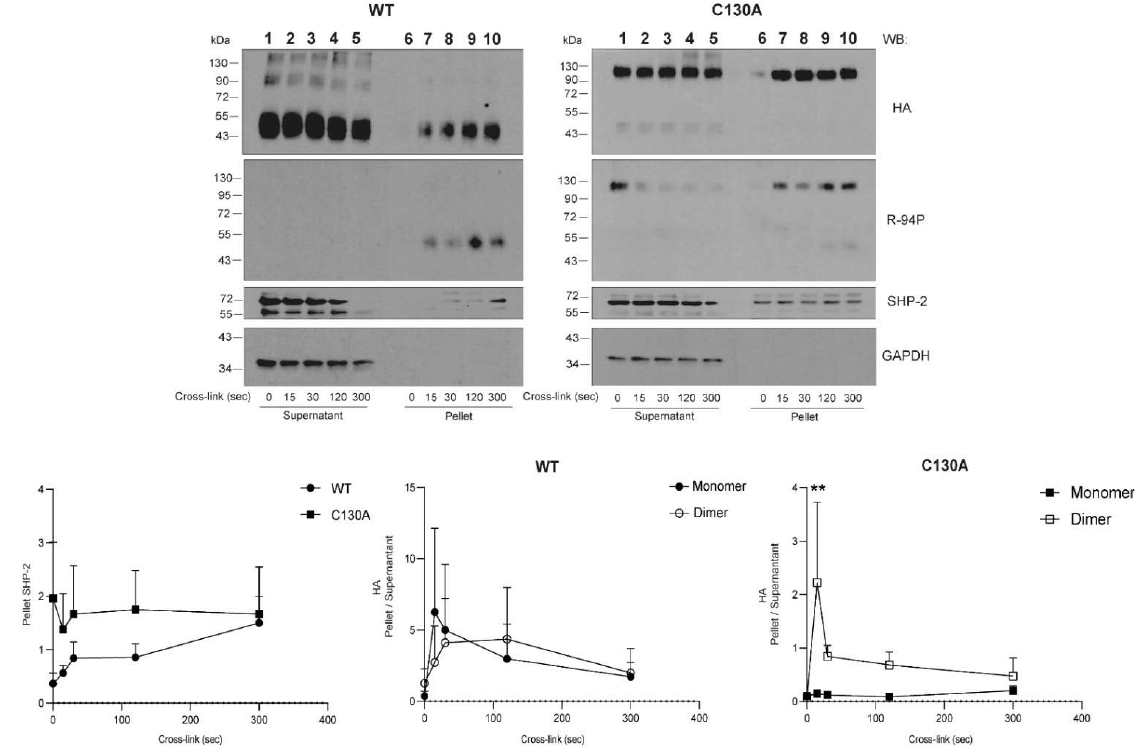
Figure 5. The C130 mutant enhances the recruitment of SHP-2 to the insoluble membrane fraction. Wild-type (WT) CLEC12A and C130 expressed transiently in HEK-293T cells were cross-linked with an anti-HA or a mouse isotype control antibody before cell lysis at the indicated time points as described in Materials and Methods. CLEC12A translocation from the NP40 soluble (supernatant (SN)) to insoluble pellet (P) was analysed by Western blot under non-reducing conditions with the anti-HA, R-94P, anti-SHP-2 and anti-GAPDH (loading control) antibodies. These data are representative of 3 independent experiments. Densitometry analysis was performed for both constructs as follows, at the indicated time points. The proportion of SHP-2 in the pellet relative to the amount of pellet CLEC12A-HA was calculated as the ratio of pellet (SHP-2/GADPH)/(anti-HA/GADPH) in the left graph . The proportion of oligomers and monomers that translocated to the pellet was calculated as the ratio of pellet anti-HA/supernatant anti-HA signal, shown in the middle graph for WT CLEC12A and C130A in the right graph . Statistical analysis: Uncorrected Fisher’s LSD test ** p < 0.01.